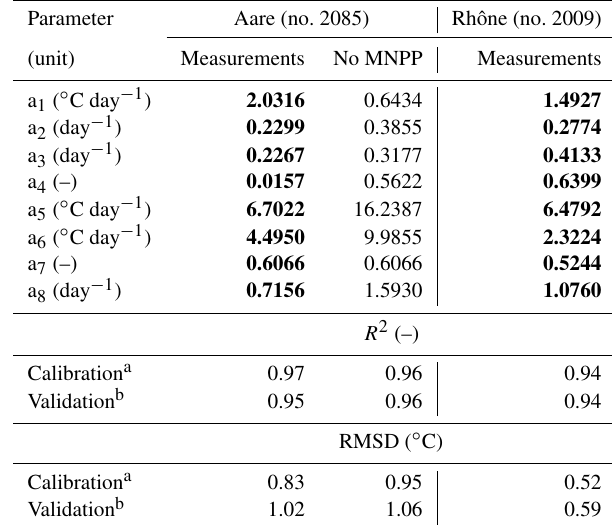
Table 1. air2stream river temperature model best-fit parameters and model performance statistics reported as coefficients of determina- tion ( R 2 ) and root mean square deviation (RMSD). Input param- eters used in this study are shown in bold-faced type. The model was calibrated, validated and subjected to sensitivity tests using data from station no. 2085 (Aare River) representing past observed con- ditions and future predicted conditions assuming MNPP removal (No MNPP).